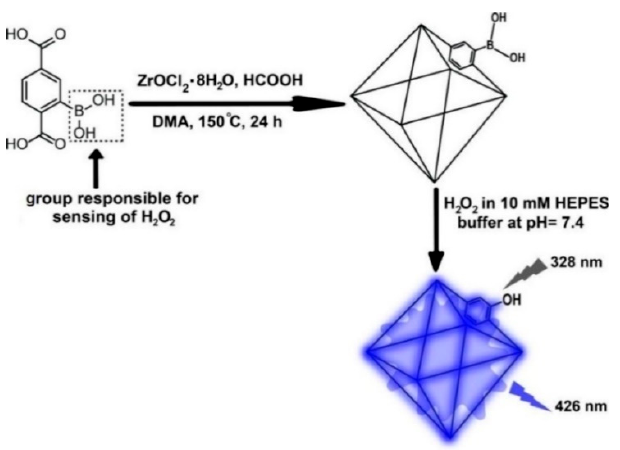
Figure 6. Synthesis of Zr-UiO-66-B(OH) 2 for the selective fluorescent detection of H 2 O 2 in HEPES buffer solutions. Reprinted with permission from [109]. Copyright (2018) American Chemical Society.